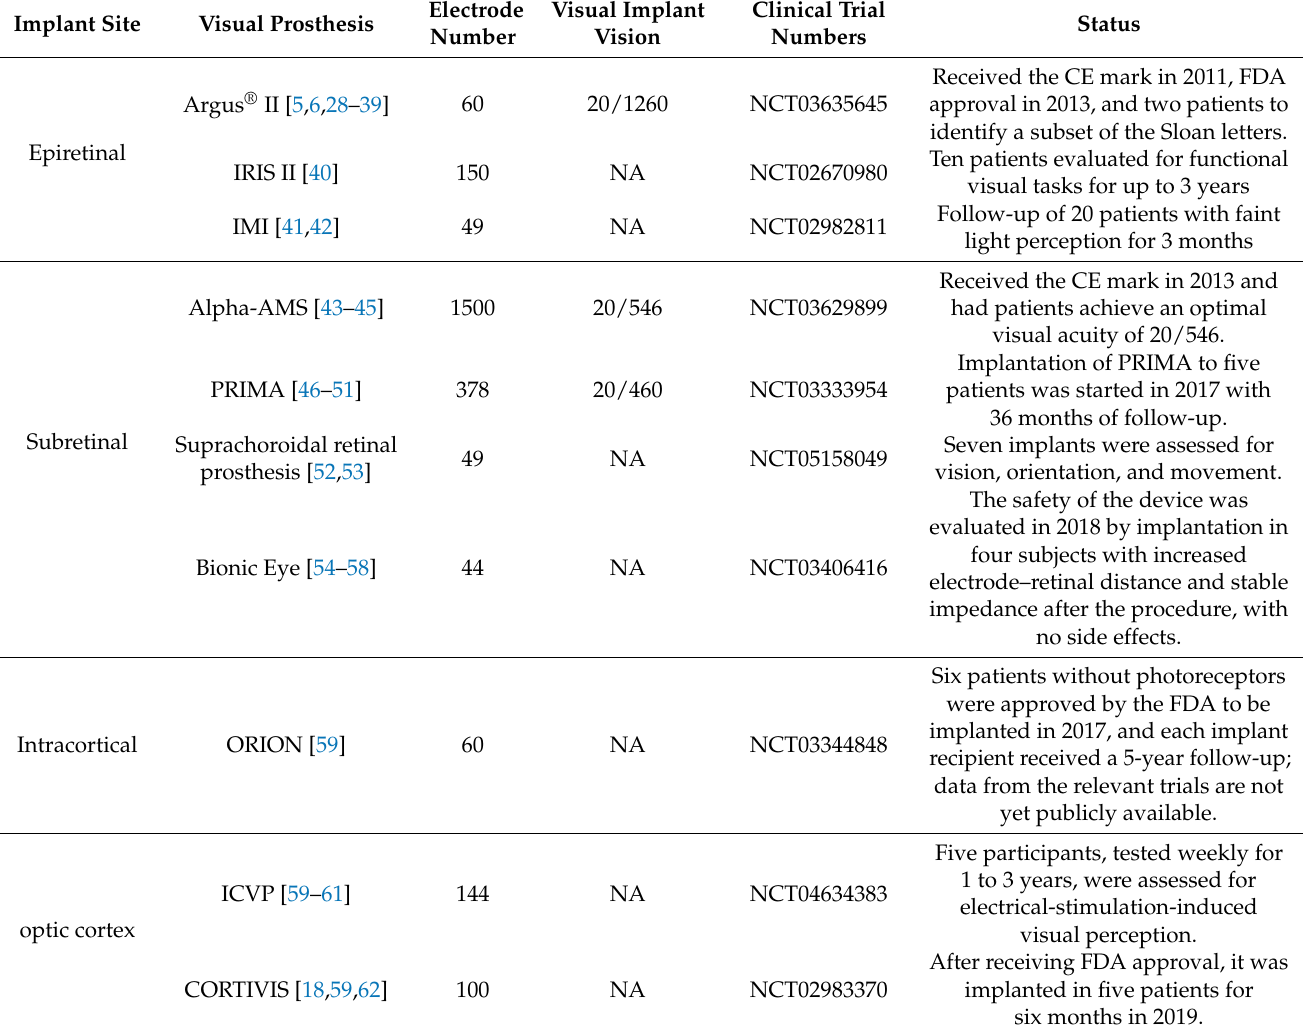
Table 1. Progress on clinical trials of visual